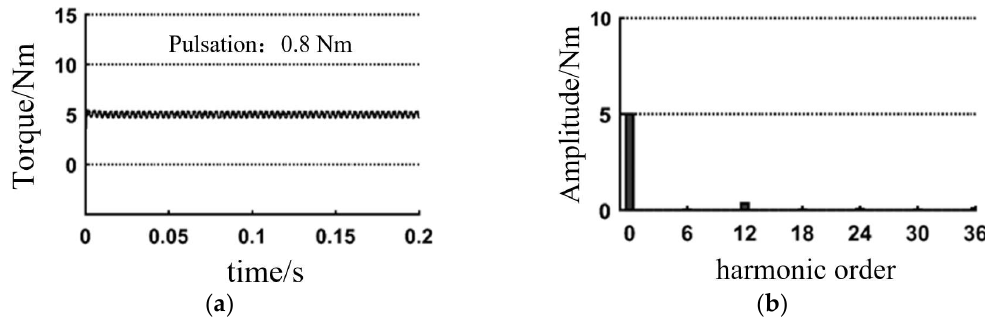
Figure 4. Simulation results with feedforward controller. ( a ) Torque wave; ( b ) FFT analysis of torque wave.